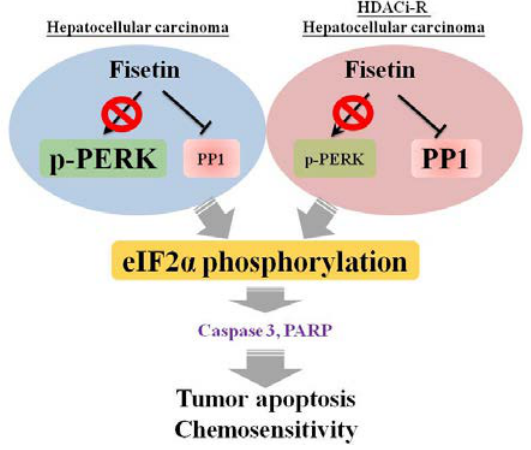
Figure 8. Schematic representation of fisetin-induced chemosensitivity via p-eIF2 α and the inhibition of PP1 in HCC cells.